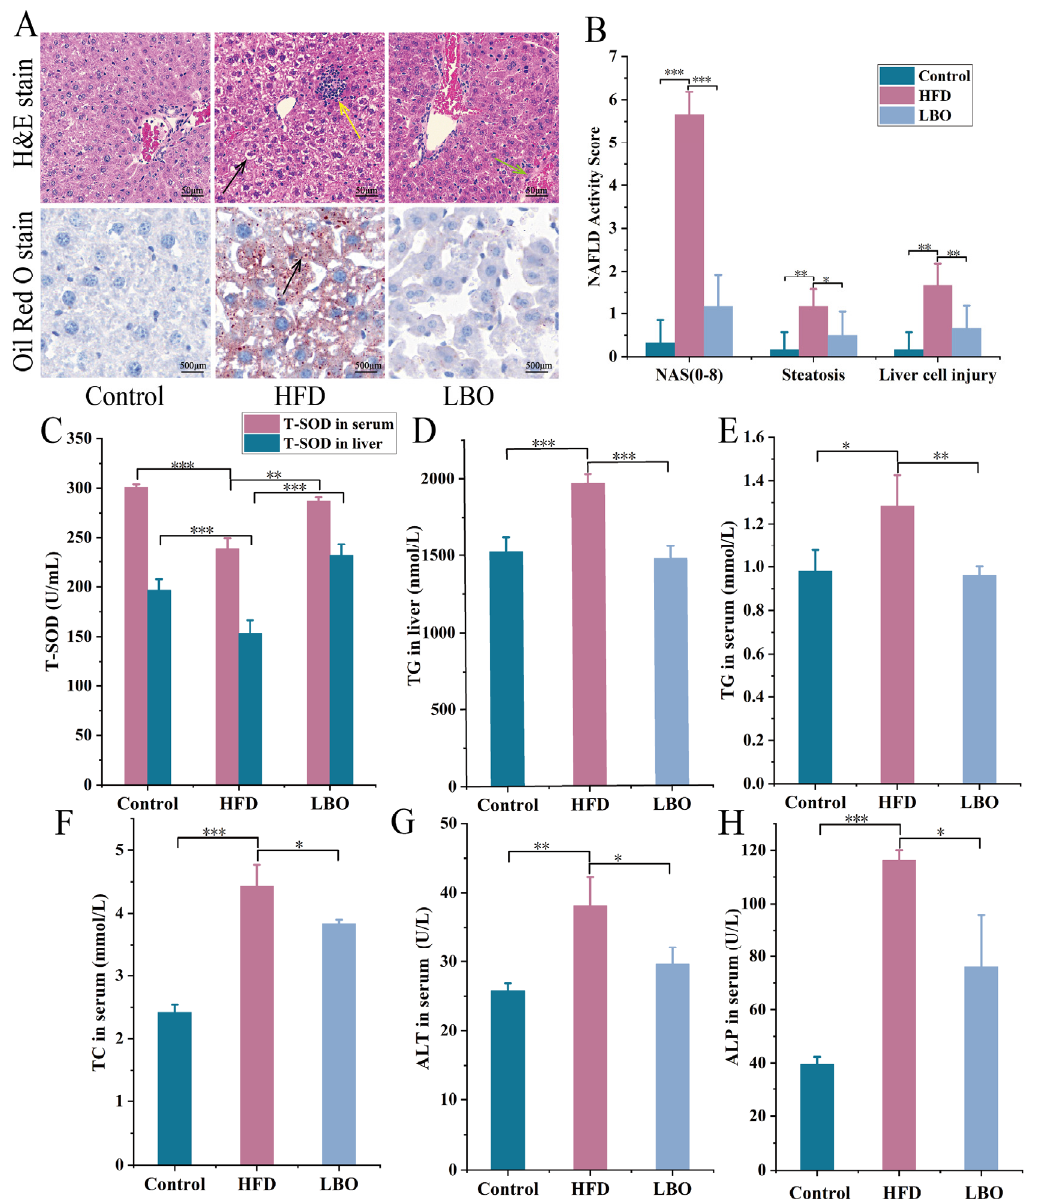
Figure 3. Alleviating efficacy of LBO on hepatic injury in HFD mice. ( A ) H&E staining of the liver (200×) and Oil Red O staining. In H&E staining, black arrows denote swollen liver cells with vacuolated cytoplasm, and yellow arrows reveal inflammatory cell infiltration. In Oil Red O staining, the black arrows represent lipid droplets in the liver. ( B ) NAFLD activity scores. ( C ) The level of T-SOD in liver and serum. ( D ) TG levels in serum, ( E ) TG levels in the liver, ( F ) serum TC level, ( G ) ALT level, and ( H ) ALP level. Values are presented as the mean ± SD, n = 6. * p < 0.05, ** p < 0.01, *** p < 0.001. LBO: Lycium barbarum oligosaccharide; HFD: high-fat diet; NAFLD: nonalcoholic fatty liver disease; T-SOD: total superoxide dismutase; TG: triglycerides; TC: total cholesterol; ALT: alanine aminotransferase; ALP: alkaline phosphatase.